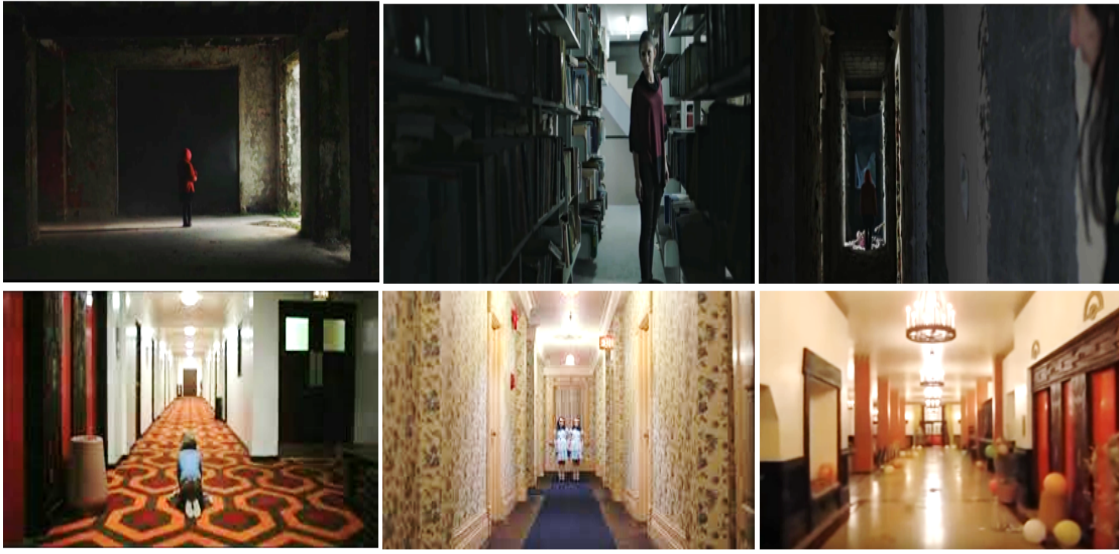
Figure 13: Bouchnak's Kubrickian inspirations in Dachra, with reference to The